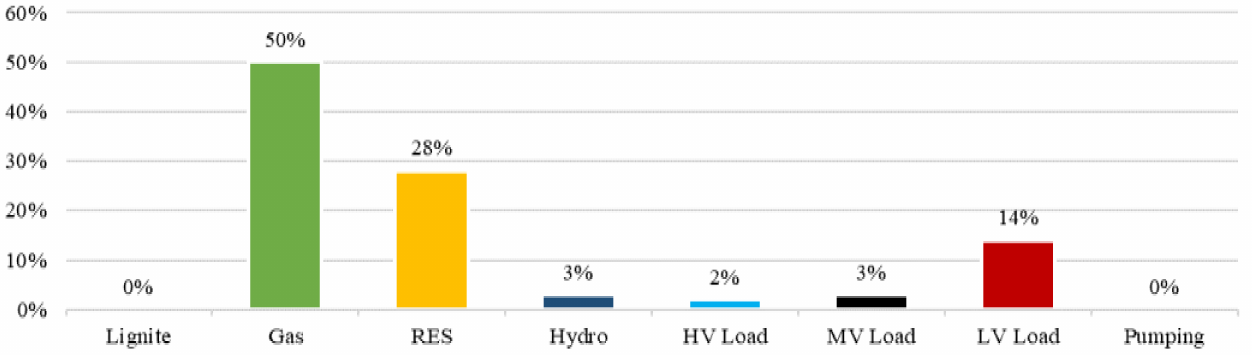
Figure 10. Intraday—Buy Volume mix (%), (May 2021), Source: Hellenic Energy Exchange and Authors’ estimations.